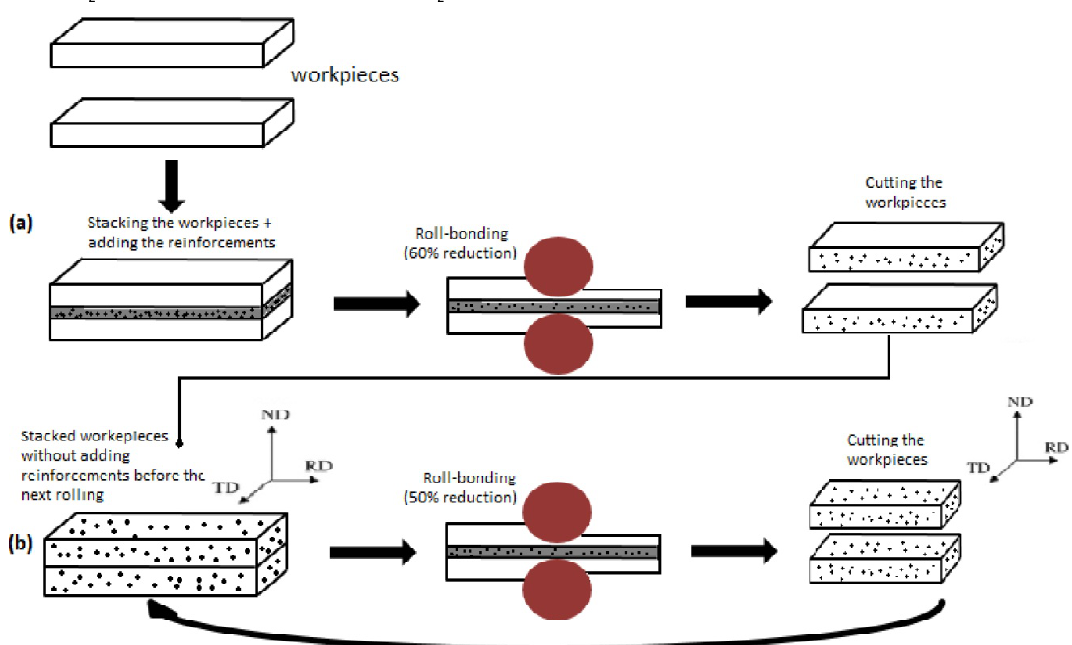
Fig. 1. TiO detection in the Al-0.5 wt.% TiO 2